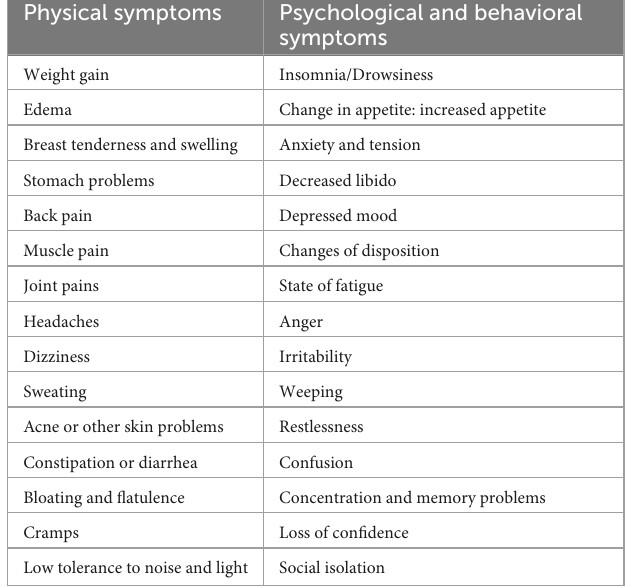
TABLE 1 The most common symptoms of premenstrual syndrome